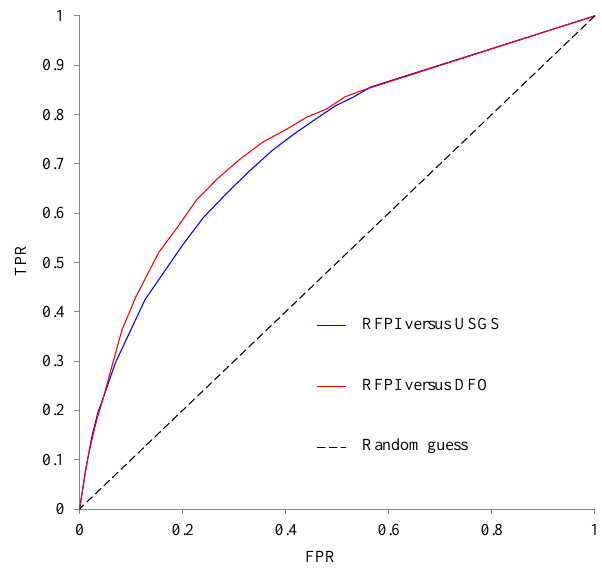
Figure 5. The ROC curves for RFPI when compared with the USGS- and DFO-reported floods.